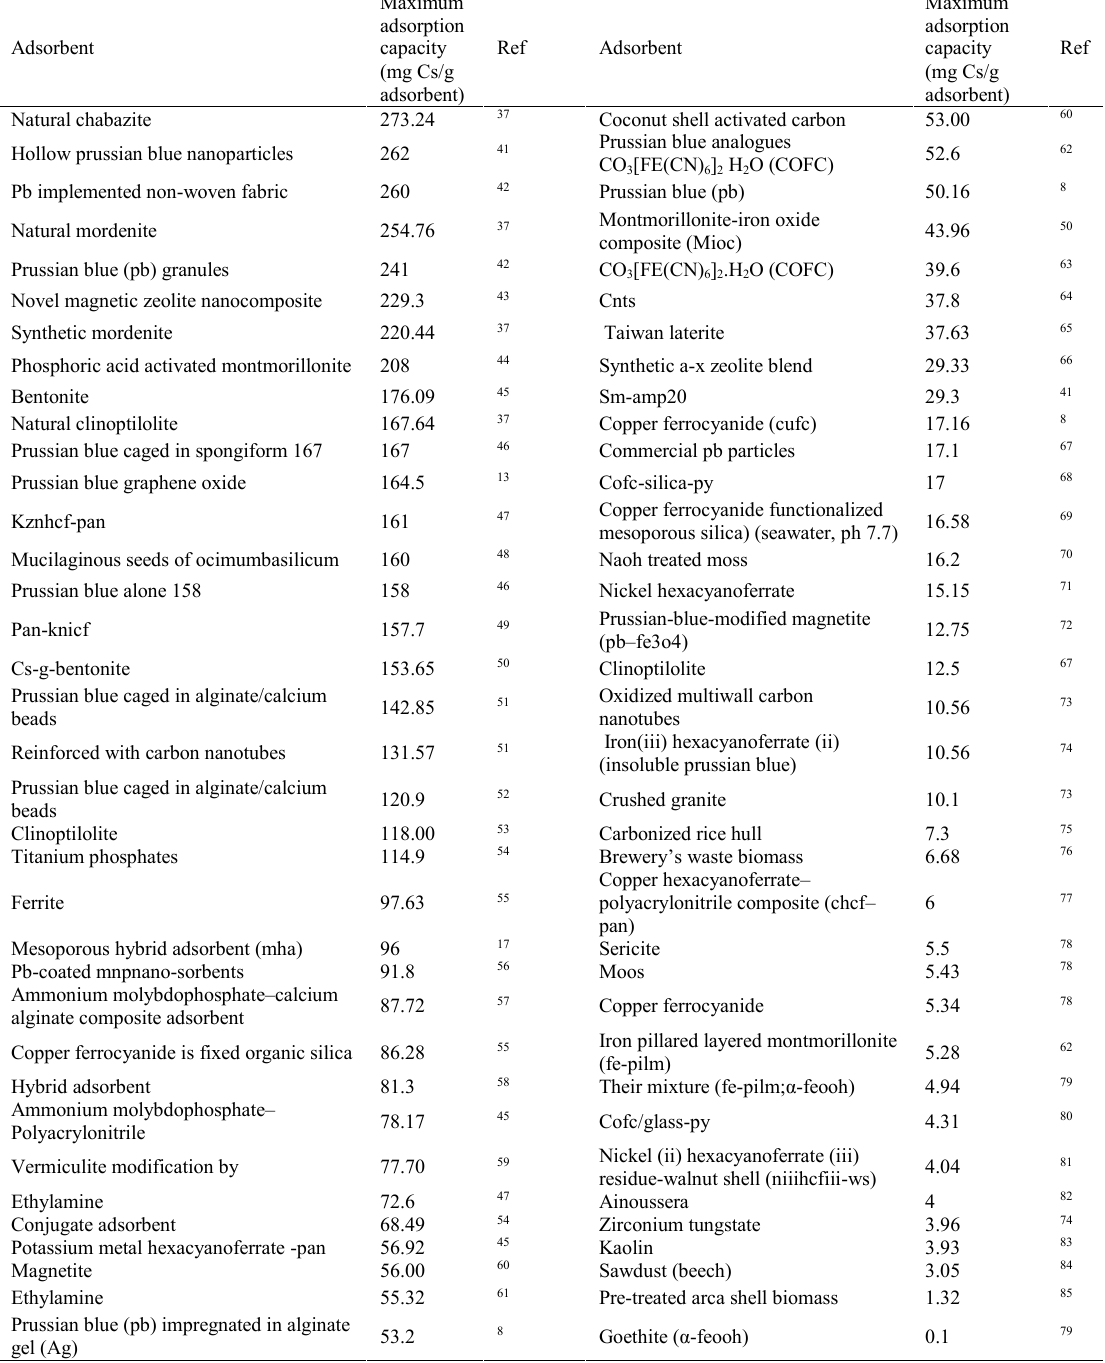
Table 1. Recent studies for Cs adsorbents considering maximum